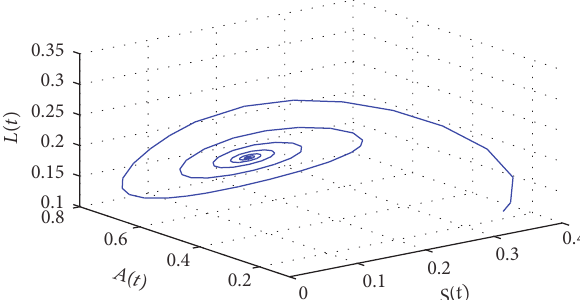
Figure 6: The phase plot of states 𝑆 ∗ , 𝐿 ∗ , and 𝐴 ∗ with 𝜏 2 = 58.48 < 95.9606 =